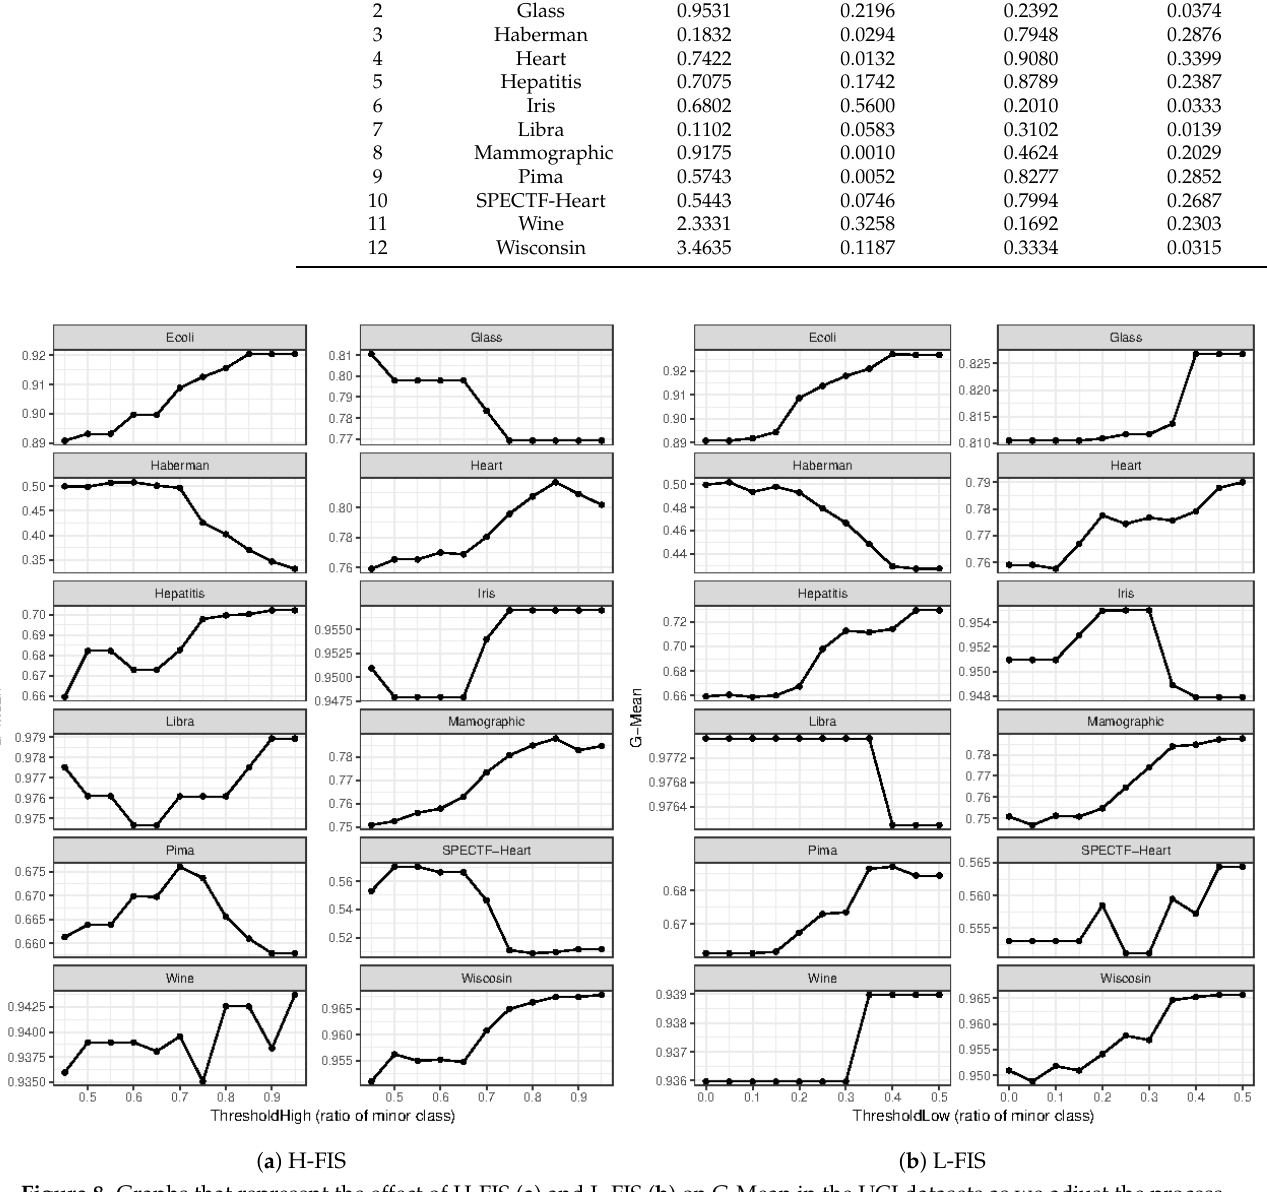
Figure 8. Graphs that represent the effect of H-FIS ( a ) and L-FIS ( b ) on G-Mean in the UCI datasets as we adjust the process to be more aggressive in the removal of the points. The point to the left of the graph represents the initial point without